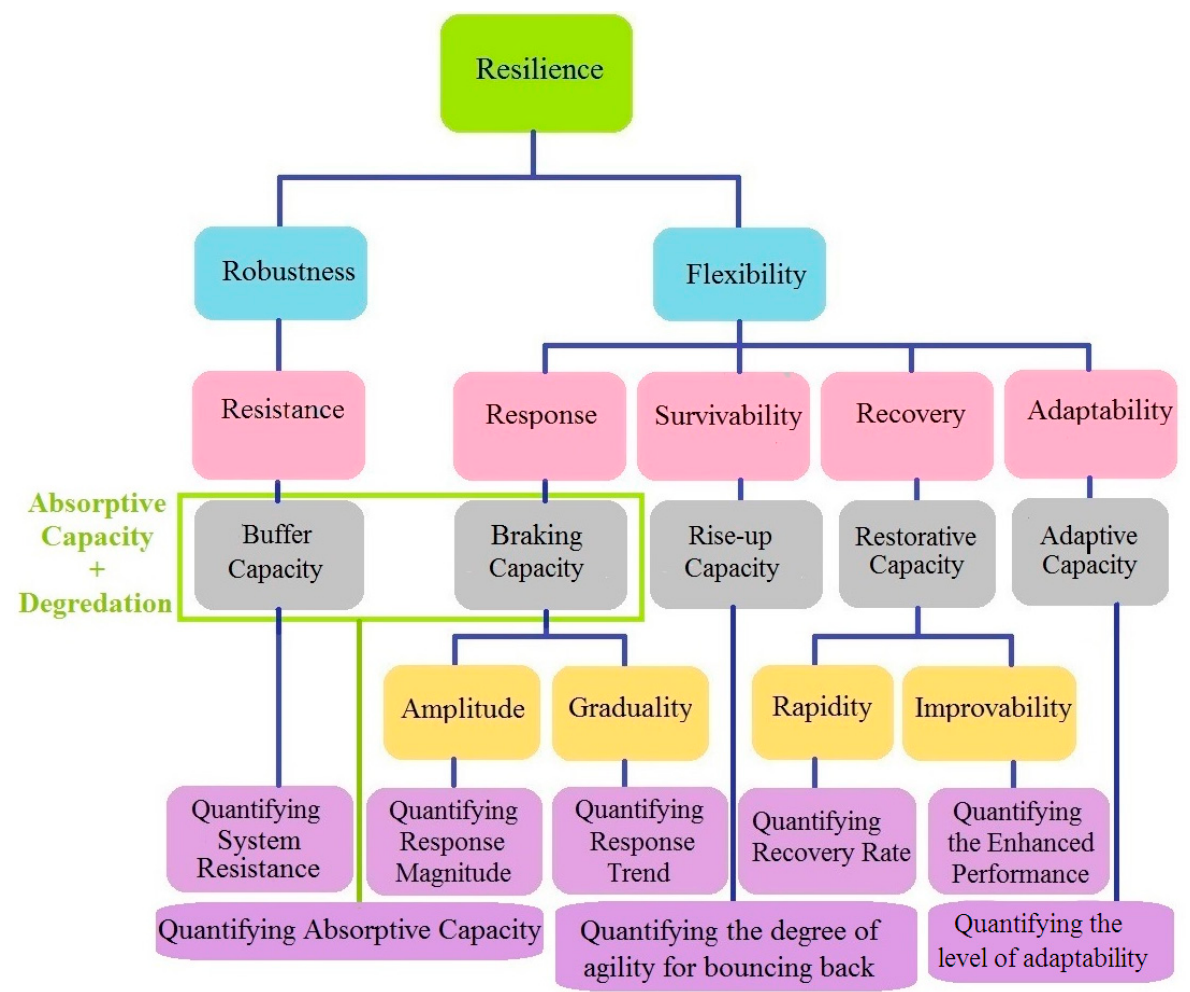
Figure 2. The proposed framework for quantifying system resiliency to disasters.